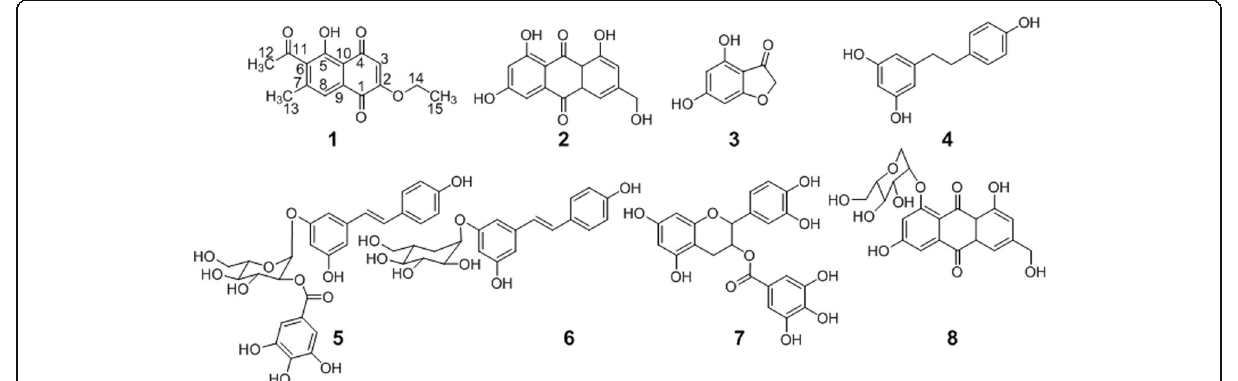
Fig. 1 Chemical structures of compounds 1 – 8 isolated from P.cuspidatum